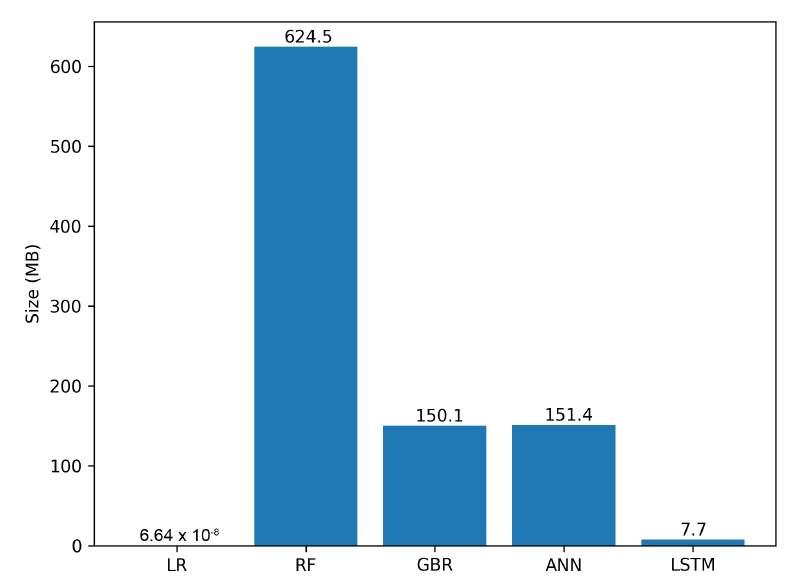
Figure 8. Comparison of the ML models size.